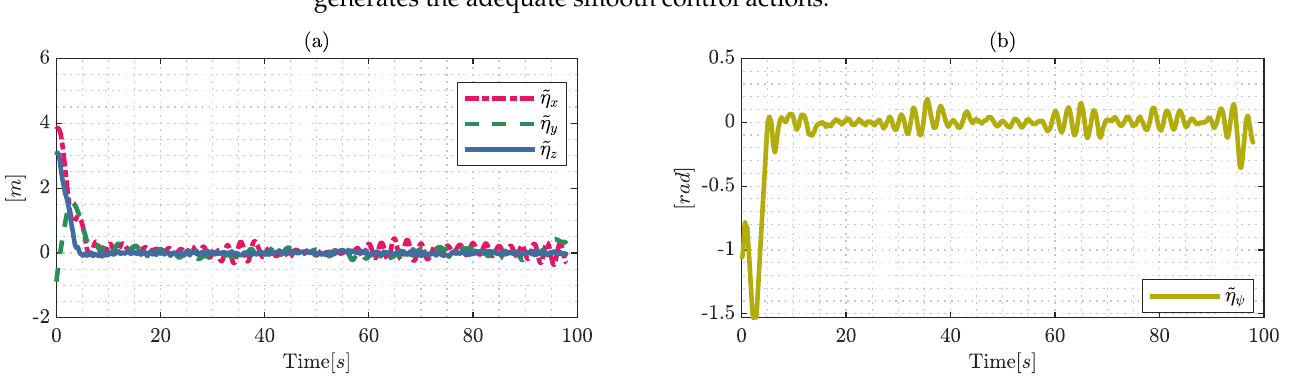
Figure 13. Control errors during a real outdoor experiment: ( a ) represents the error in the work-space (cid:8) (cid:9) I x , I y , I z ; and ( b ) shows the results with respect to the desired angular position.